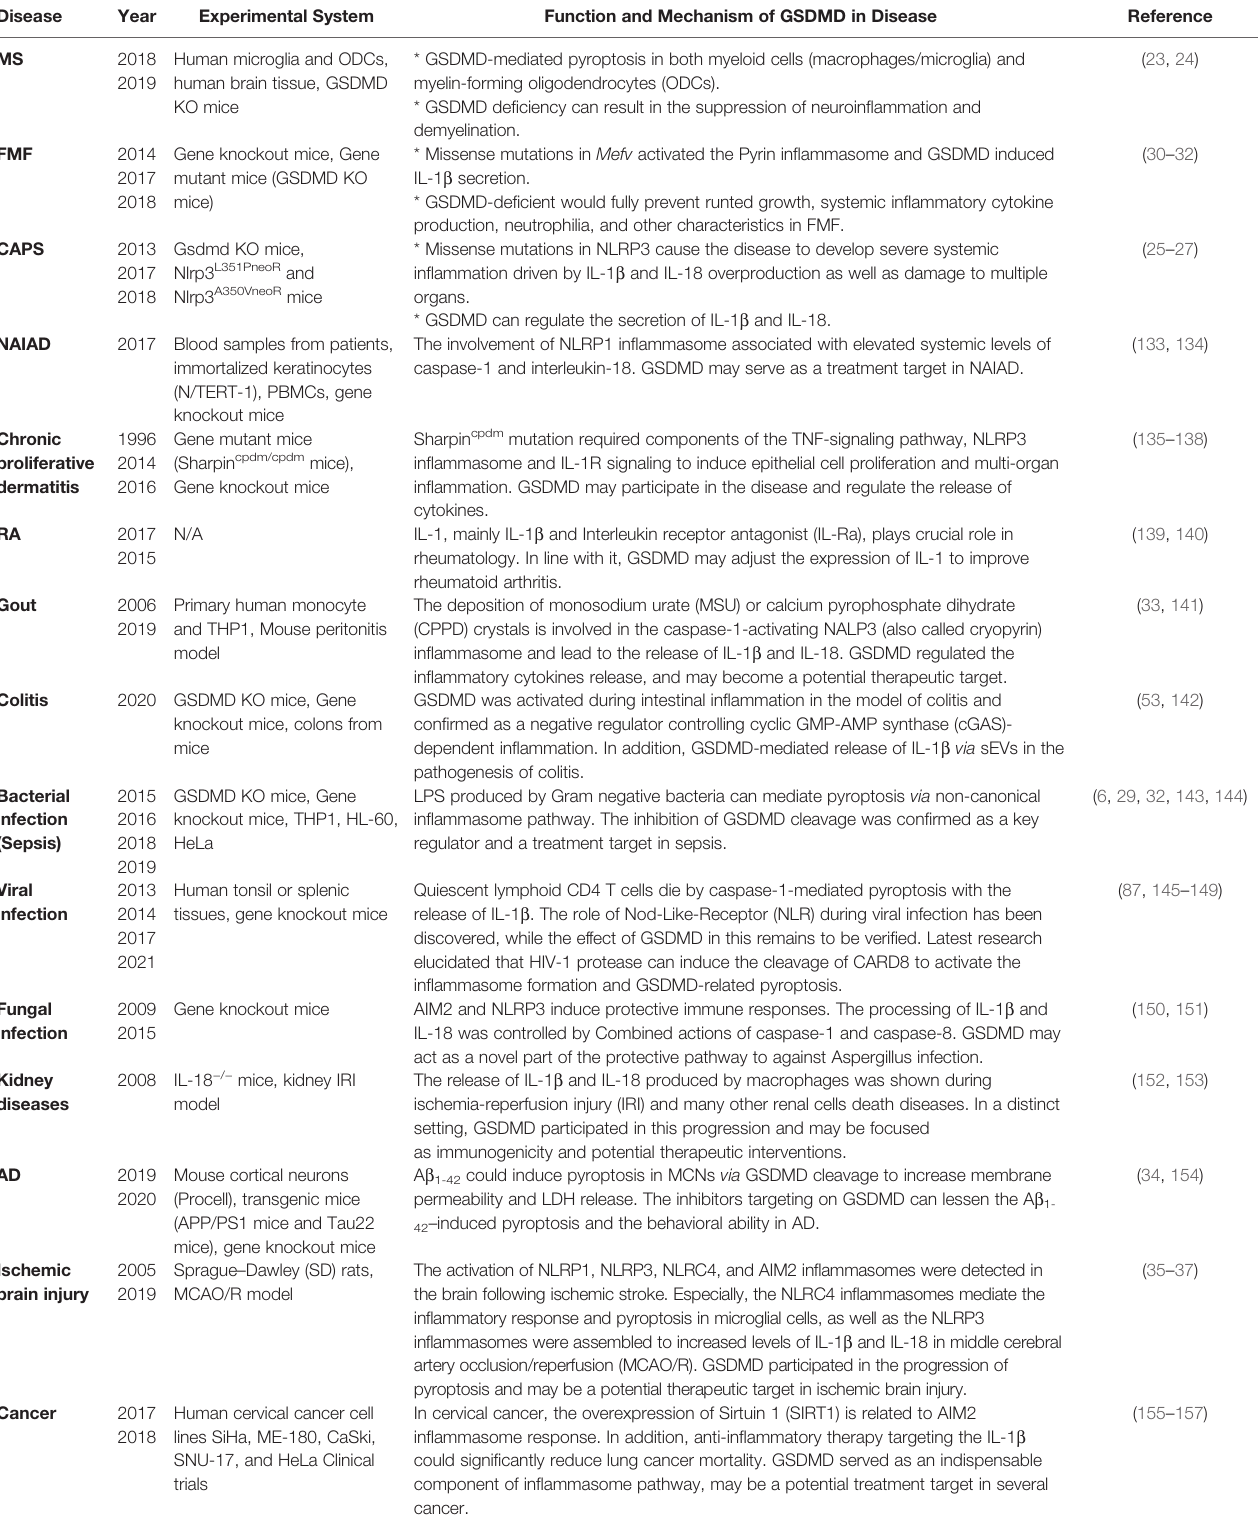
TABLE 2 | GSDMD and autoimmune/in fl ammatory/infection/metabolic and systemic diseases.